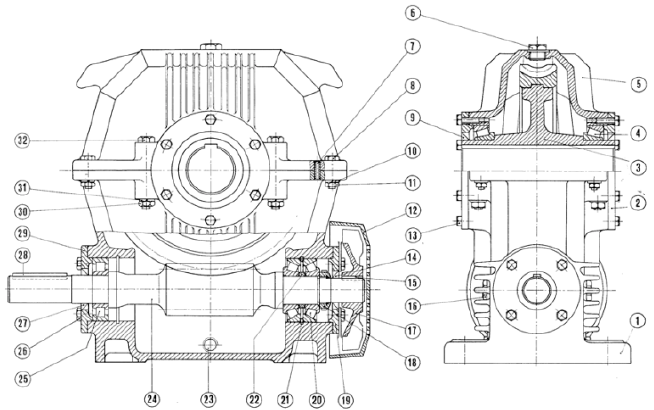
Figure 6. RV 250 gearbox from the design of the Rossi Motoriduttori—Modena.